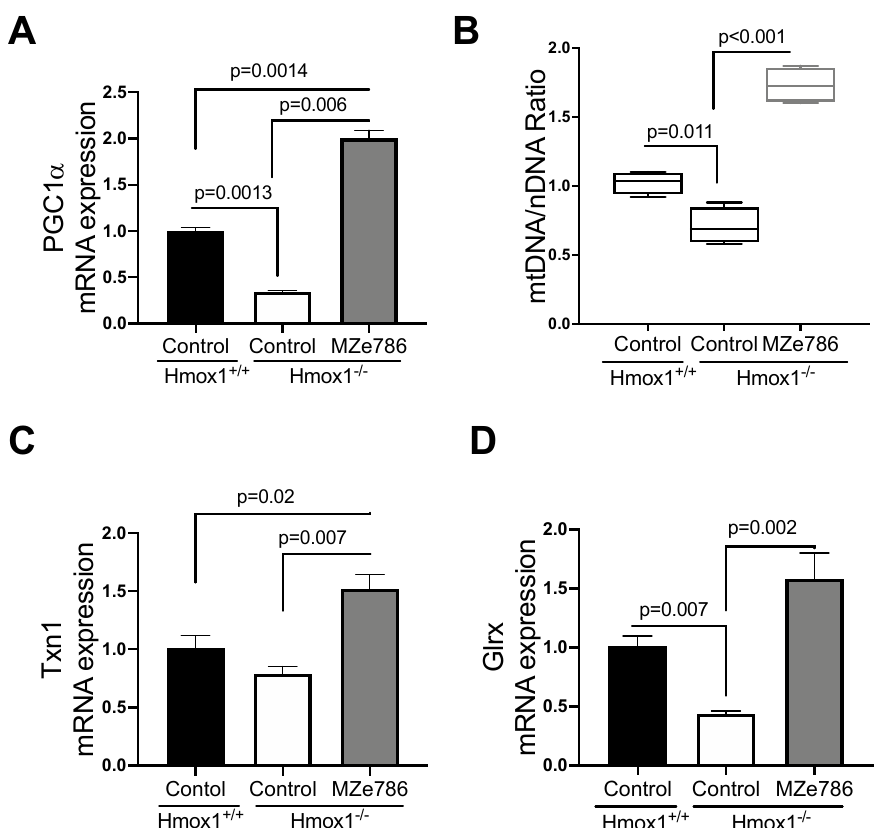
Figure 2. MZe786 stimulates antioxidant genes transcription in Hmox1 knockout mice. ( A ) Relative PGC1 α mRNA expression, ( B ) content of mitochondria expressed as the ratio of mitochondrial DNA by nuclear DNA (mtDNA / nDNA). ( C ) Relative mRNA expression of antioxidant gene thioredoxin (Txn1) and ( D ) glutaredoxin (Glrx) measured by qPCR in heart tissue from Hmox1 +/+ and Hmox1 − / − mice exposed to MZe786 via gavage. A, C and D values are expressed as means ± SEM. Values in B are expressed as median and whiskers represent maximum and minimum values. N =